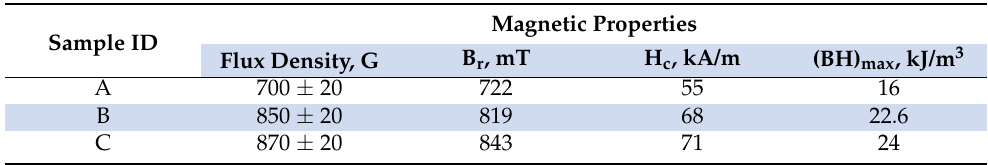
Table 2. Magnetic properties of the studied Sample A alloy, Sample B alloy and Sample C alloy after complete treatment investigating the alloy system.